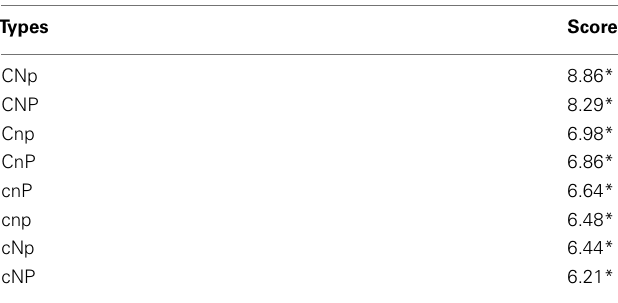
Table 2 | Ranking of spatial association between pairs of different genotypes, with average z -score and complementation score, defined as the number of loci at which they have different alleles.